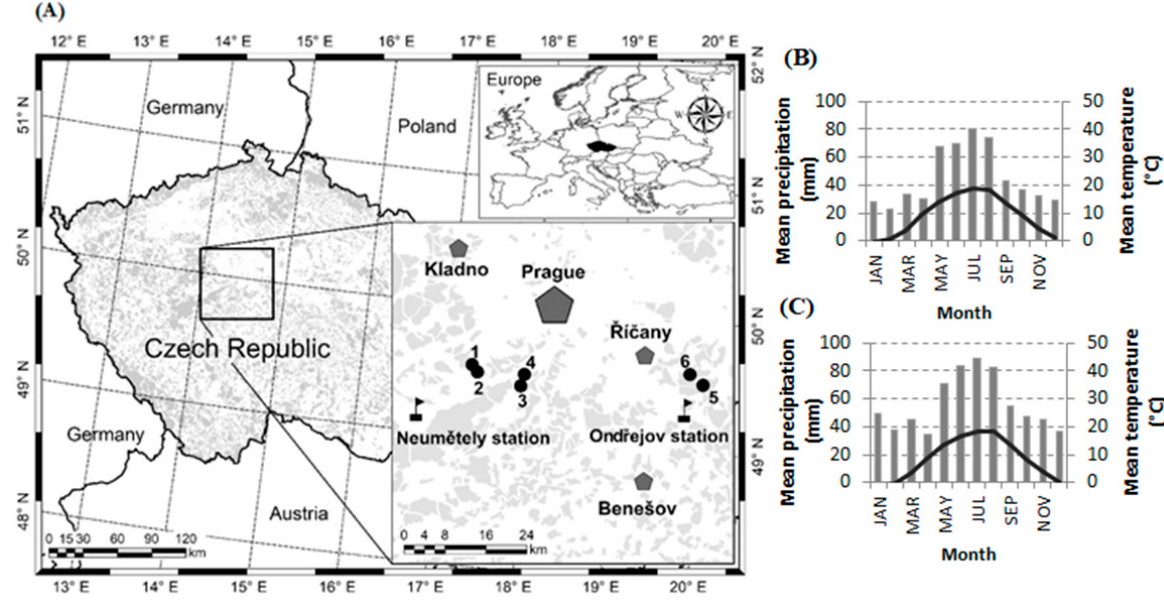
Figure 1. Location of Norway spruce stands on research plots ( • ) in the study areas of Karlstejn (1–2), Cukrak (3–4) and Kostelec (5–6); meteorological stations ( ) ( A ); pentagons mean big cities; the shadowed areas are forested areas; the map was made in ArcGIS 10 software (Esri). Climogram for Karlstejn and Cukrak research plots ( B ); Climogram for Kostelec research plots ( C ). Table 1. Overview of the sites and stand characteristics of research plots (according to the Forest Management